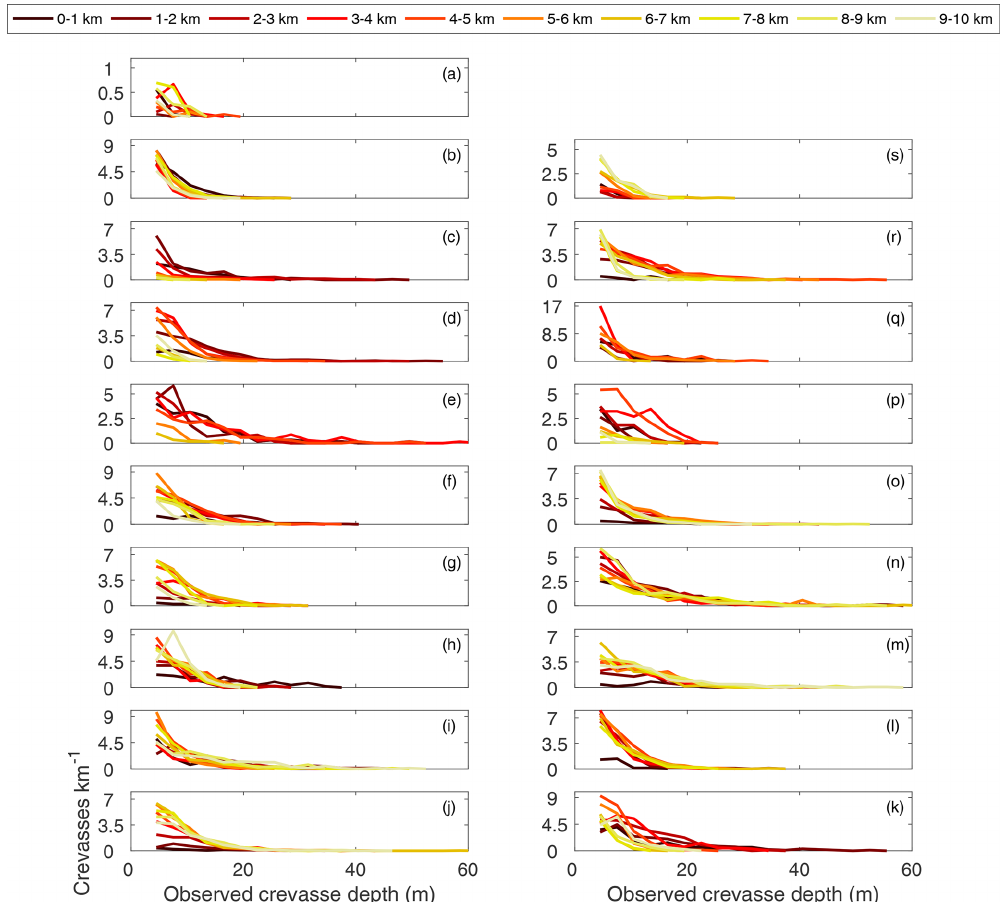
Figure 2. Observed crevasse depth distributions for 1km wide bins over the first 10km of each glacier. The distance from the terminus of each bin is distinguished by line color. Differences in area under the curves reflect variations in observed crevasse concentration between bins. Panels are geographically arranged so that western glaciers are on the left and eastern glaciers are on the right. Common names (with Greenlandic names in parentheses) are (a) Ryder Glacier, (b) Harald Moltke Bræ (Ullip Sermia), (c) Kong Oscar Glacier (Nuussuup Sermia), (d) Illiup Sermia, (e) Upernavik North Isstrøm, (f) Upernavik Isstrøm (Sermeq), (g) Inngia Isbræ (Salliarutsip Sermia), (h) Umiammakku Sermiat, (i) Rink Isbræ (Kangilliup Sermia), (j) Jakobshavn Isbræ (Sermeq Kujalleq), (k) Heimdal Glacier, (l) Køge Bugt Glacier, (m) Hel- heim Glacier, (n) Midgård Glacier, (o) Kangerlussuaq Glacier, (p) Dendrit Glacier, (q) Magga Dan Glacier, (r) Daugaard–Jensen Glacier and (s) Zachariæ